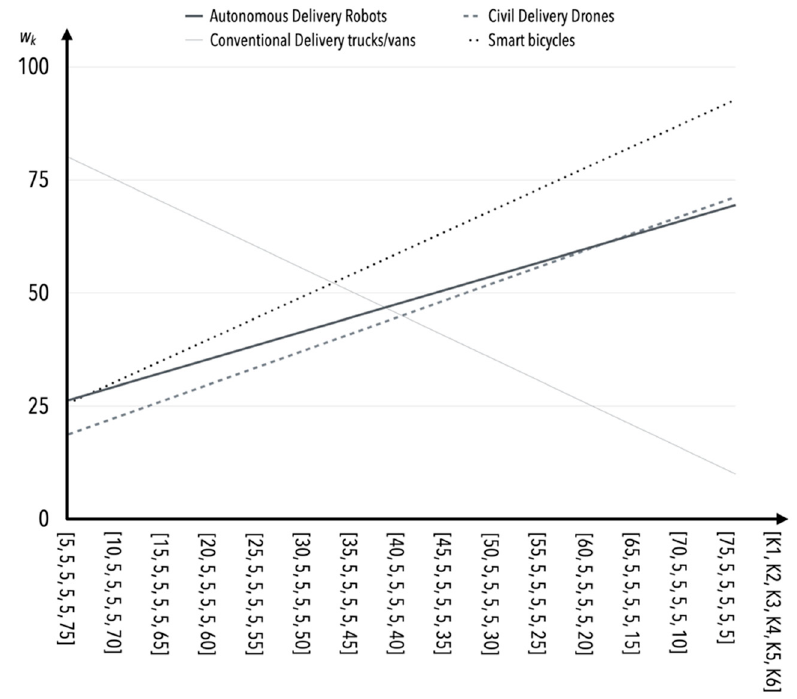
Figure 6. The influence of weight value changes for criterion K 5 on criteria K 1 –K 4 (in the case of S1).